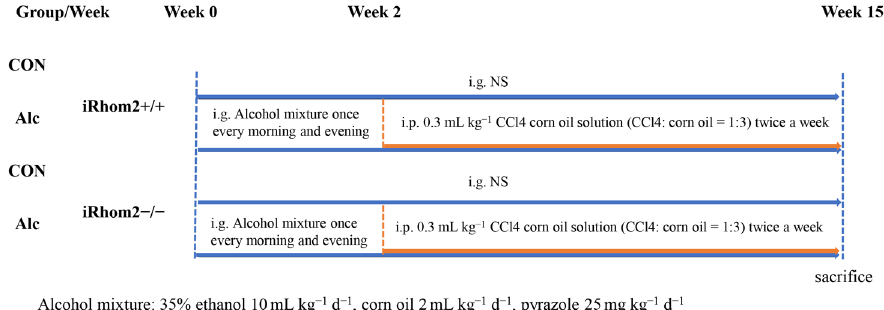
Figure 8. Schematic of the experiment design.